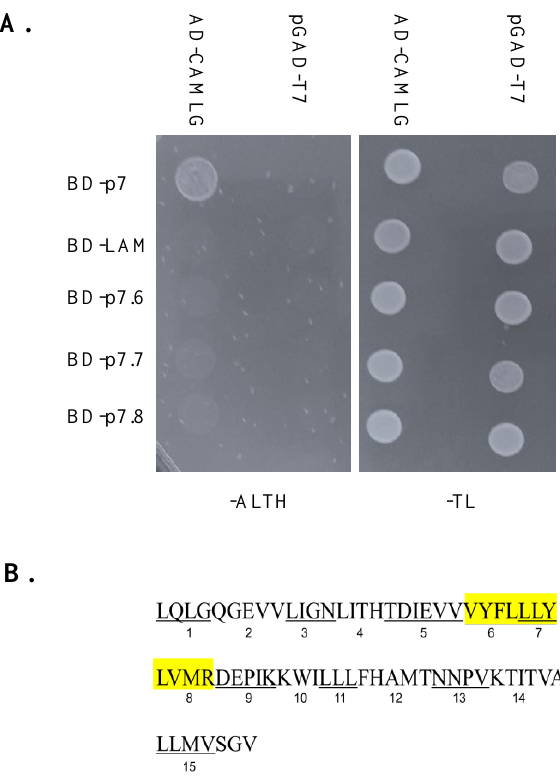
Figure 1. Interaction of CSFV p7 protein and host CAMLG detected by yeast two-hybrid system. ( A ) Yeast strain AH109 was transformed with either GAL4-binding domain (BD) fused to CSFV p7 (BD-p7), or mutated CSFV p7 construct as indicated or human lamin C (BD-LAM), a negative control and GAL4 activation domain (AD) fused to CAMLG (AD-CAMLG) or the negative control pGADT7 as indicated. 2 × 10 6 yeast cells were spotted onto either SD-Ade/His/Leu/Trp plates (-ALTH), selective media for detecting protein-protein interactions or nonselective SD-Leu/Trp plates (-TL) ( B ) Schematic representation of CSFV p7 alanine mutants used in the present study. The name of each alanine p7 mutant is shown below the mutated amino acid residues for each particular mutant. All indicated residues were mutated to an alanine. The highlighted p7 mutants indicate alanine substitutions resulting in lack of binding of p7 to CAMLG in the yeast two-hybrid system.